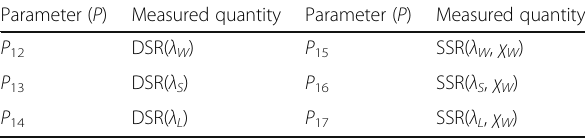
Table 7 Measured quantities ( P 12 – P 17 ) of DSR and SSR for TCWV retrieval Parameter ( P ) Measured quantity Parameter ( P ) Measured